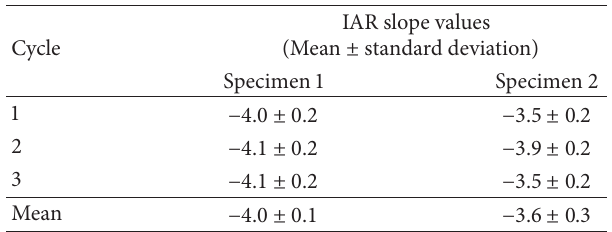
Table 4: Mean values of IAR slopes for specimen 1 and specimen 2 during plantar